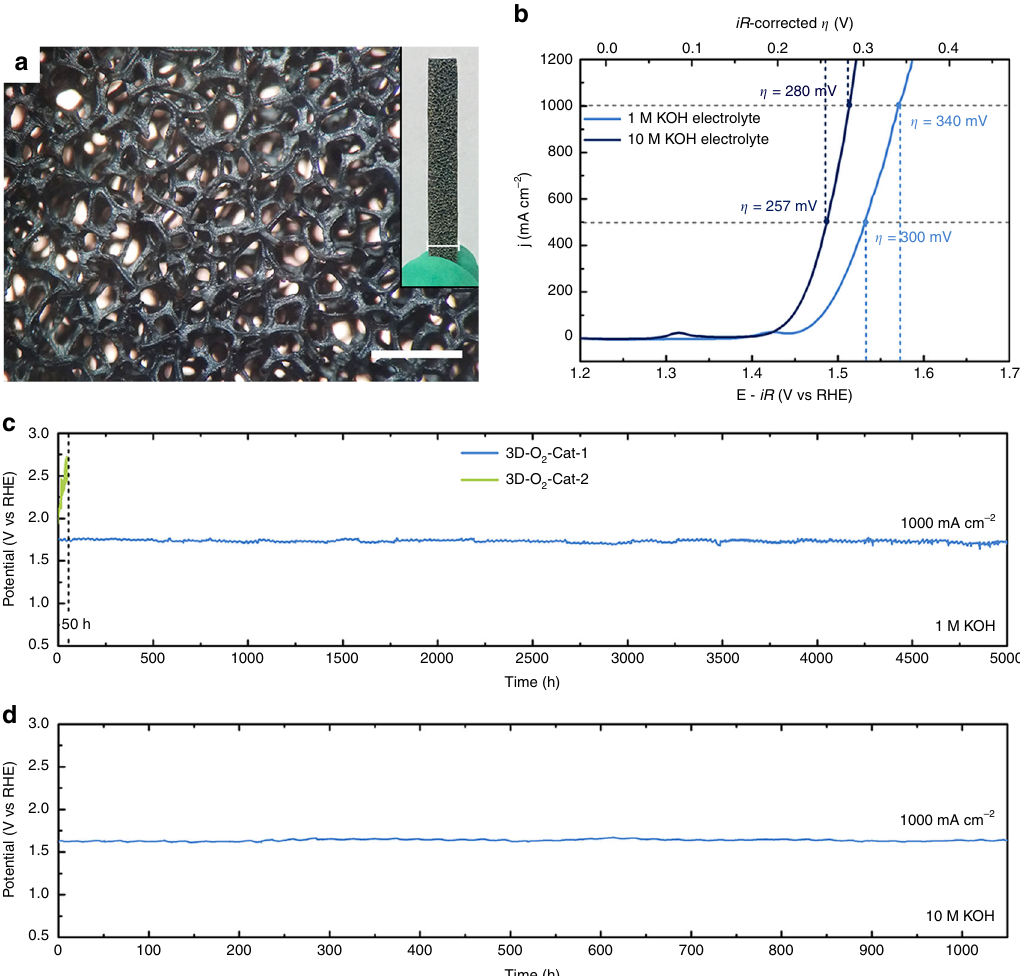
Fig. 5 Electrocatalytic properties for OER at large current densities. a Digital images and b iR -corrected polarization curves of 3D-O 2 -Cat-1 in 1 M (light blue line) and 10 M (dark blue line) KOH electrolytes under an extended current window (0-1000 mA cm − 2 ). Scale bars, 1 mm and 0.5 cm (inset). c Chronopotentiometric curves of 3D-O 2 -Cat-1 and 3D-O 2 -Cat-2 in 1 M KOH at a current density of 1000mA cm − 2 (without iR -correction) d Chronopotentiometric curve of 3D-O 2 -Cat-1 in 10 M KOH at a current density of 1000 mA cm − 2 (without iR